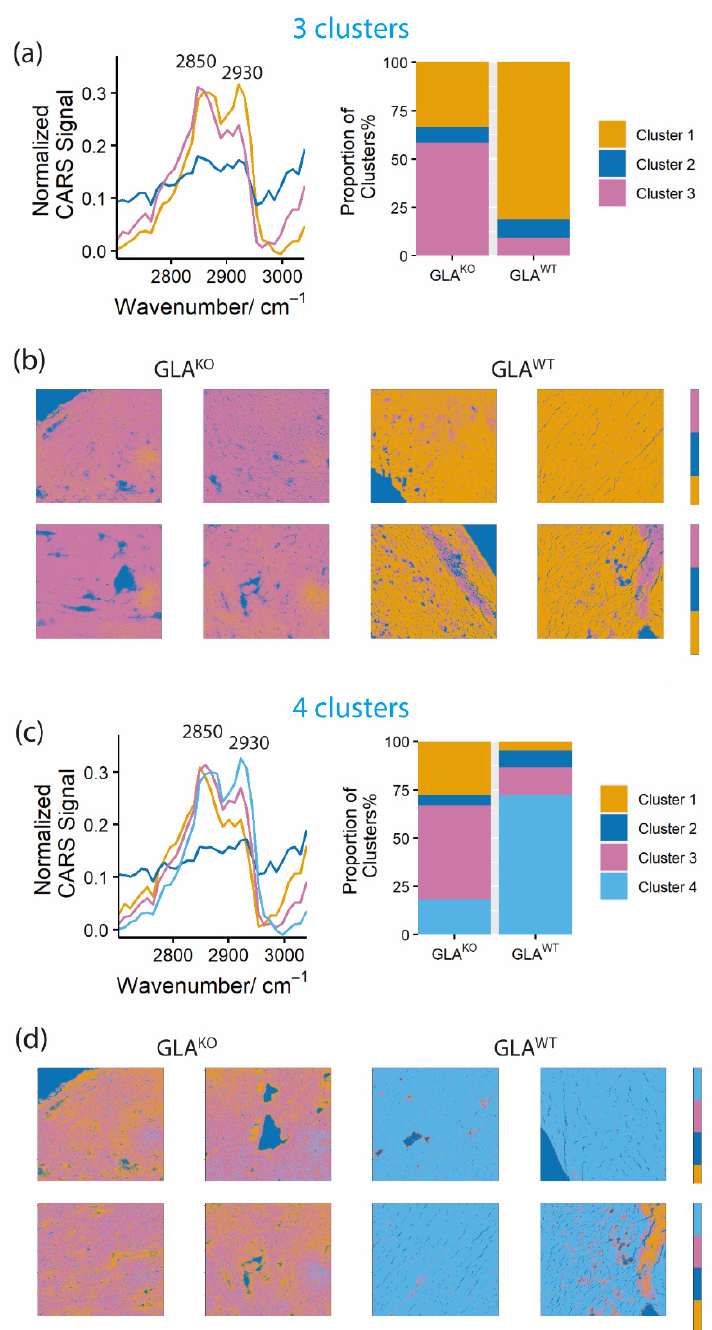
Figure 3. Clustering data analysis of CARS images of heart sections of the FD mouse model and wild-type mice allows the differentiation between knockout and wild-type mice (GLA KO , n = 35 vs. GLA WT , n = 20). K-means clustering is shown for three clusters ( a , b ) and four clusters ( c , d ). The clustering analysis was based on the ratio between lipids (CH 2 stretch vibration at ~2850 cm − 1 ) and proteins/lipids (CH 3 stretch vibration at ~2940 cm − 1 ); ( a , c ) show the mean spectra of three or four clusters, respectively, and the histograms, which display the distribution of the clusters in both genotypes in %; ( b , d ) show representative images of color maps for tissue sections of both genotypes, GLA KO vs. GLA WT (the image size is 500 µ m × 500 µ